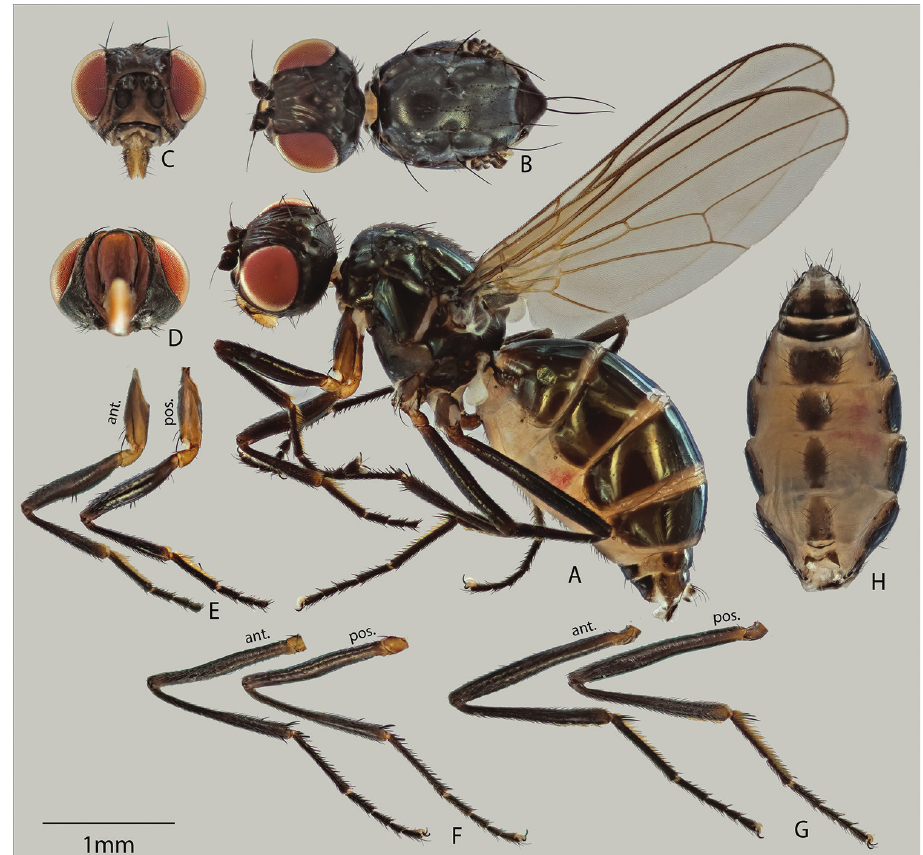
Figure 3. Adult female ( A–H ), showing lateral ( A ) and dorsal ( B ) views of habitus ( sans abdomen), ante- rior ( C ) and ventral ( D ) views of head capsule, anterior and posterior views of fore leg ( E ), mid leg ( F ) and rear leg ( G ), and ventral view of abdomen ( H ).